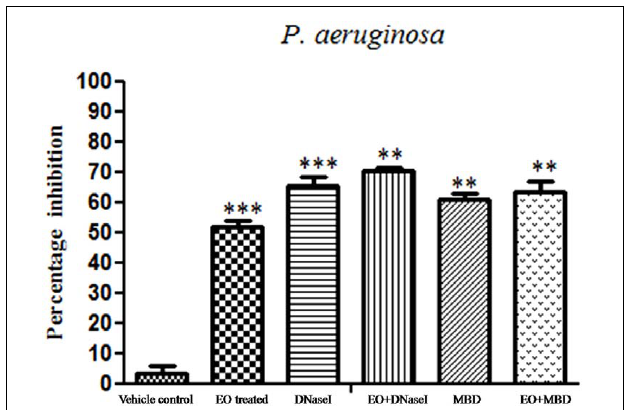
FIGURE 3 | Percentage inhibition of P. aeruginosa matured biofilm. Mean values of triplicate independent experiments ± SD are shown. One-way ANOVA test demonstrates significant difference between the control and the test. Double asterisk indicates significant at P ≤ 0.01 and triple asterisk indicates significant at P ≤ 0.005.